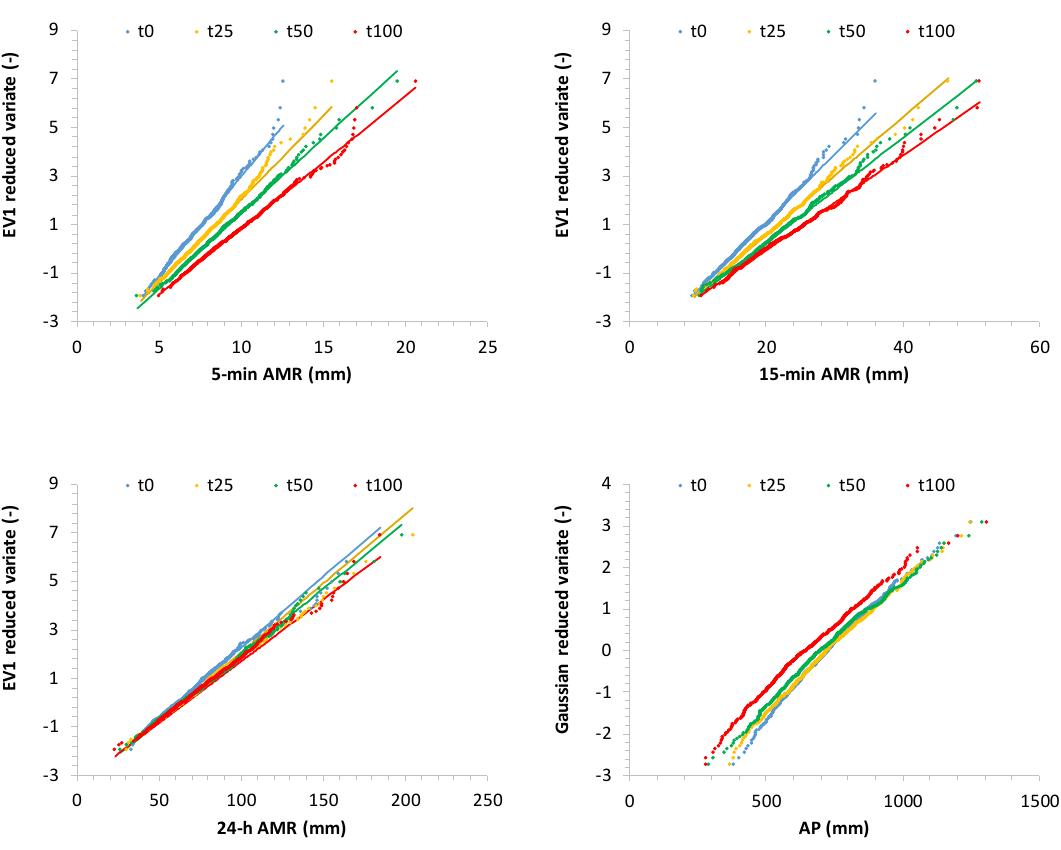
Figure 6. Viterbo rain gauge: evolution of frequency distributions for some investigated time series. Table 5. Evolution of average values for Annual Maximum Rainfall (AMR) and of Mean Annual Precipitation (MAP): from now (t0) to 25 (t25), 50 (t50), 75 (t75) and 100 (t100)